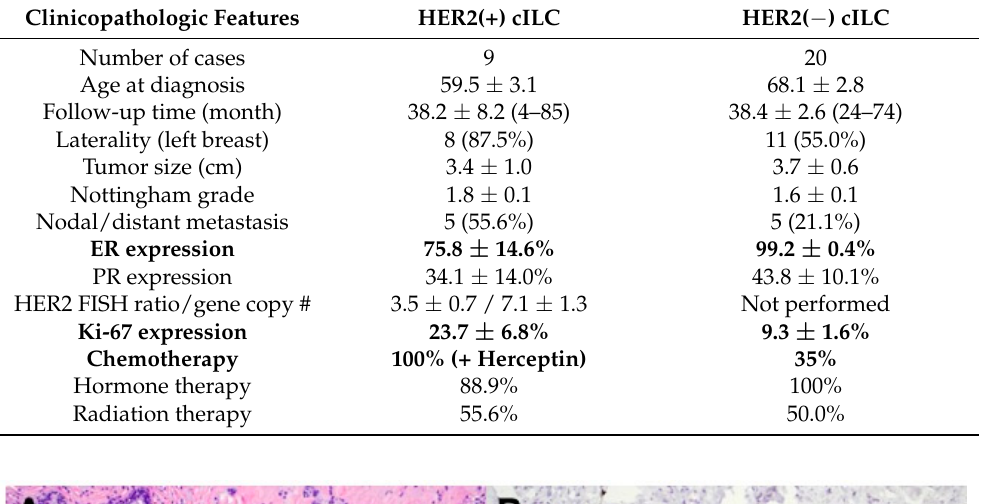
1611 Table 1. Comparison of clinicopathologic features between HER2(+) and HER2( − ) classical type